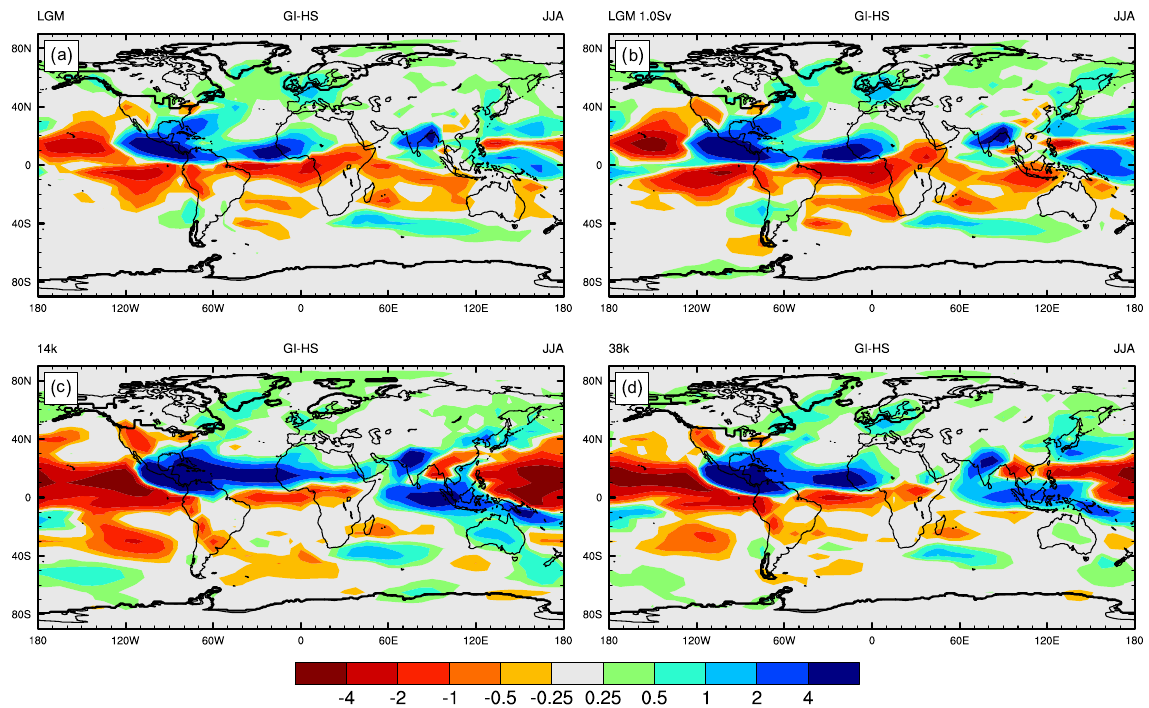
Fig. 3. As in Fig. 2 but showing summer (JJA) GI–HS precipitation anomalies (mmday − 1 ). The distribution of land ice in each simulation is shown by the black contour